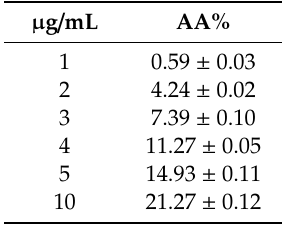
Figure 3. Effect of c Pa -SLN (1, 2, 3, 4, 5 and 10 µg/mL) on the amount of malondialdehyde equivalents (MDA Eq.) produced in the presence of the free radical FeSO 4 inducers, performed in triplicate. Trolox and water were used as the positive and the negative control, respectively. Data are presented as mean ± SEM. * p < 0.05 when compared to the negative. One-way ANOVA with Dunnet post-test was applied. Table 2. Evaluation of antioxidant activity (% scavenging of free radical DPPH) of perillaldehyde 1,2-epoxide from c Pa -SLN.